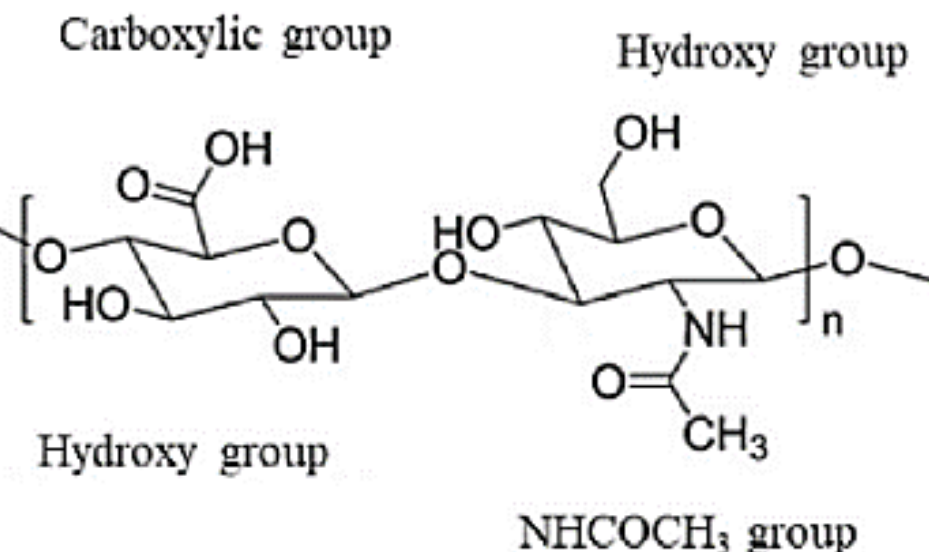
Figure 5. Chemical structure of hyaluronic acid [146]